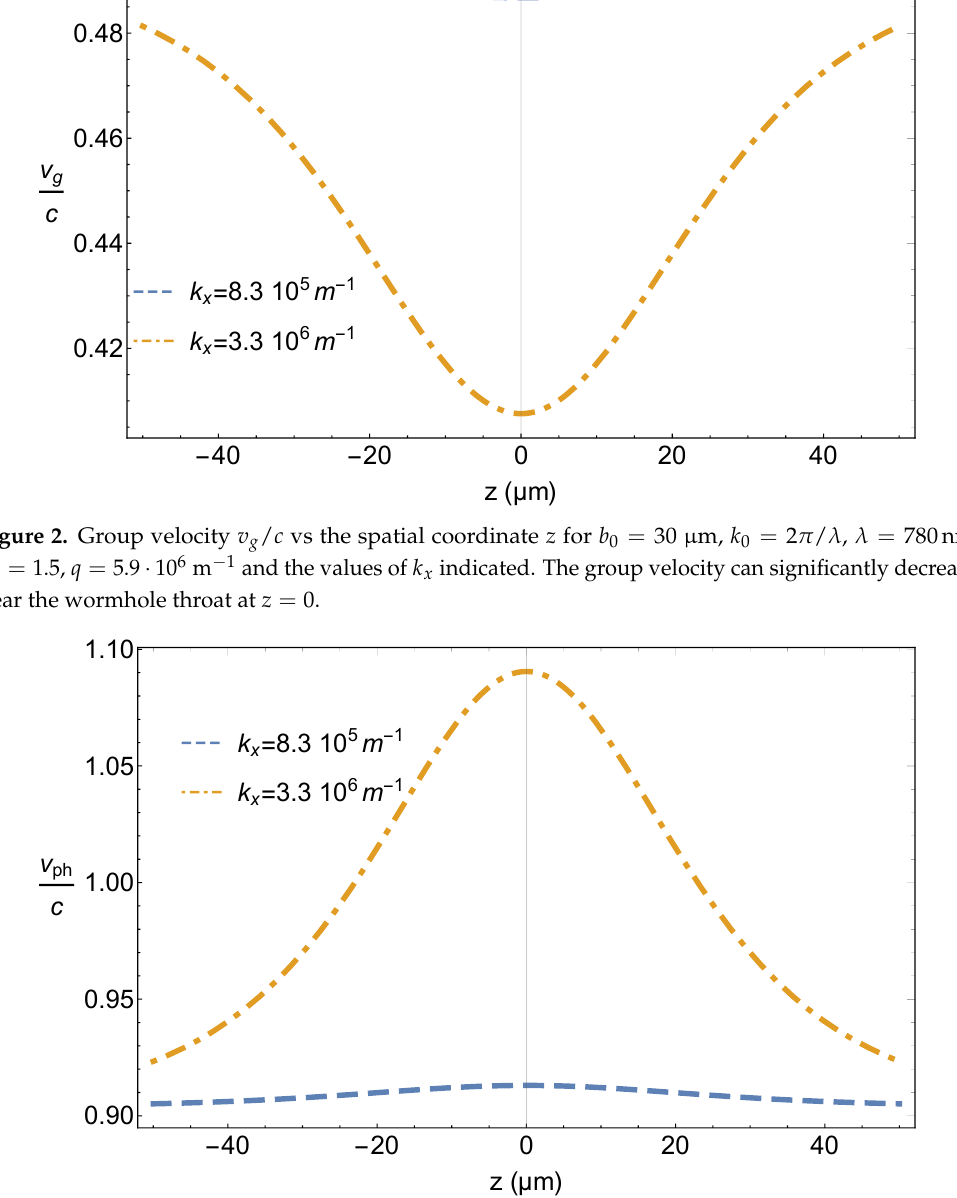
Figure 3. Phase velocity v p h / c vs the spatial coordinate z for b 0 = 30 µ m, k 0 = 2 π / λ , λ = 780nm, n 0 = 1.5, q = 5.9 · 10 6 m − 1 and the values of k x indicated. The phase velocity increases and can become superluminal near the